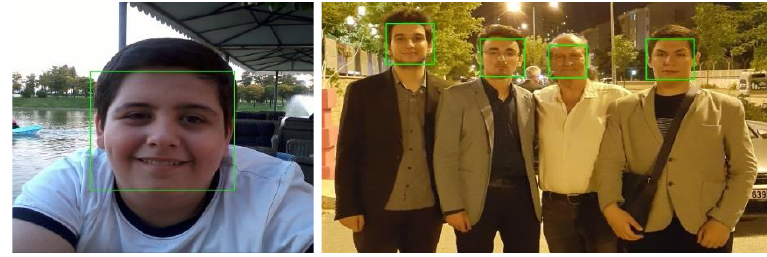
Fig. 5. D etecting a single person’s face and a group of people’s faces